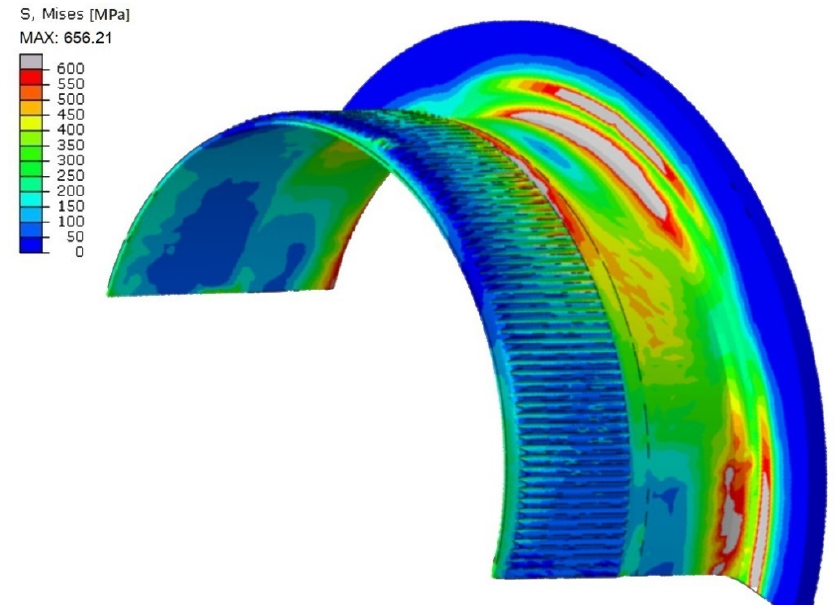
Figure 9. The distribution of the stresses in the flexspline model—variant V.